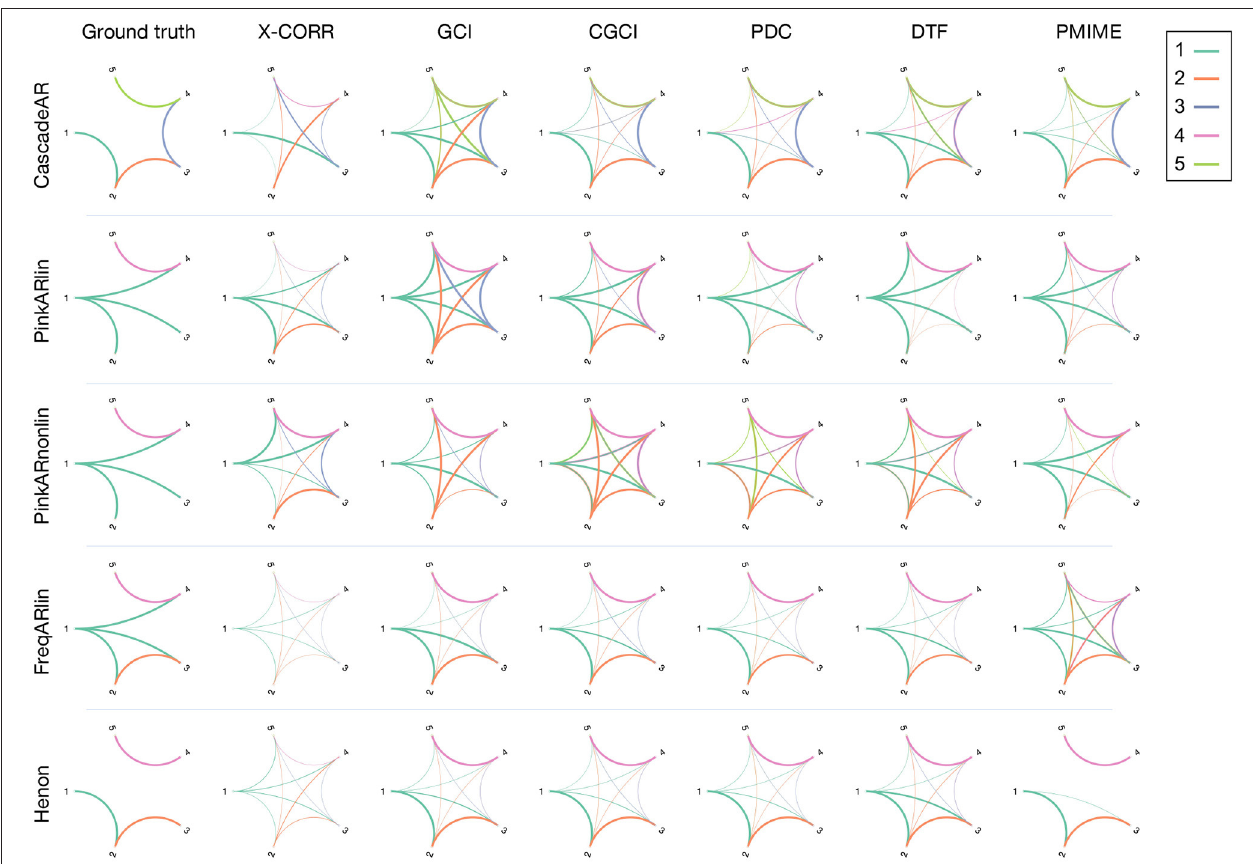
FIGURE 5 | Connectograms estimated by the different causality measure for a selection of four simulation models. The connections are colour-coded in function of the source channel and the width is proportional to the number of significant interactions found over 100 realisations of the simulation model. The first column contains the ground truth